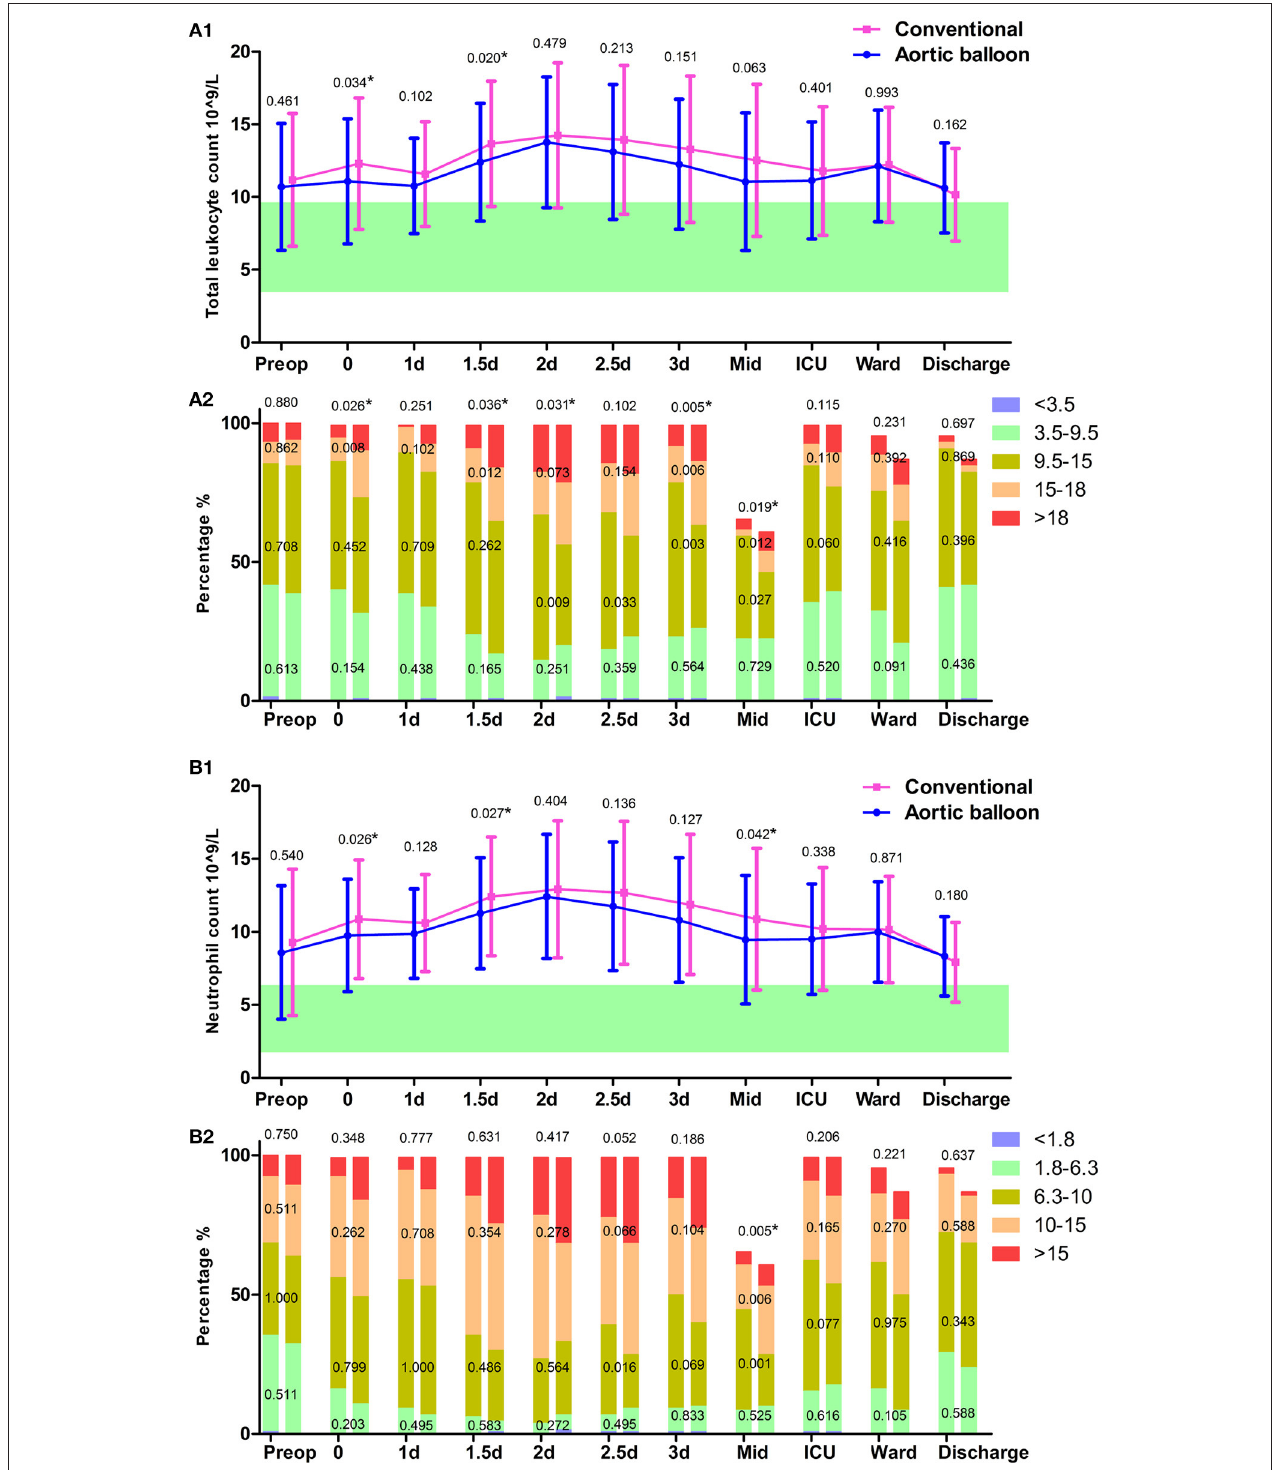
FIGURE 4 | Leukocyte test. (A1) The trajectory of total leukocyte count. (A2) Total leukocyte count grading in the column. (B1) The trajectory of neutrophil count. (B2) Neutrophil count grading in the column. Data points are represented by mean with standard deviation bars. * P < 0.05.